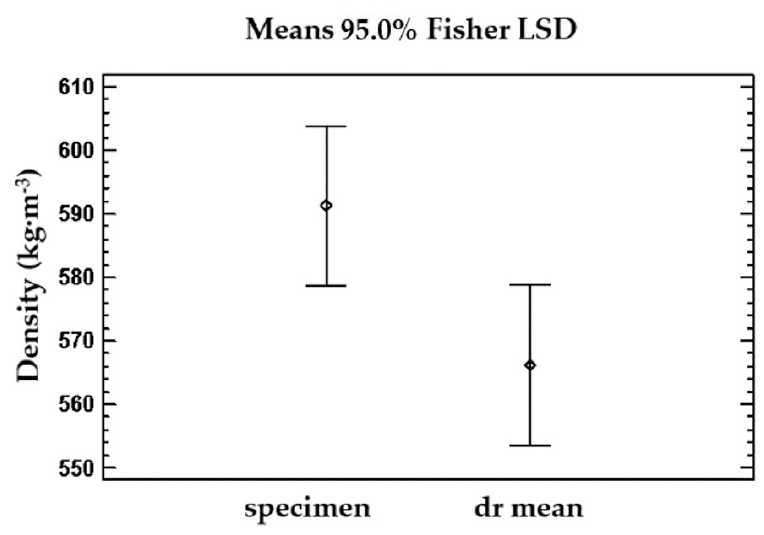
Figure 4. Means plot of density obtained by specimens and by drilling